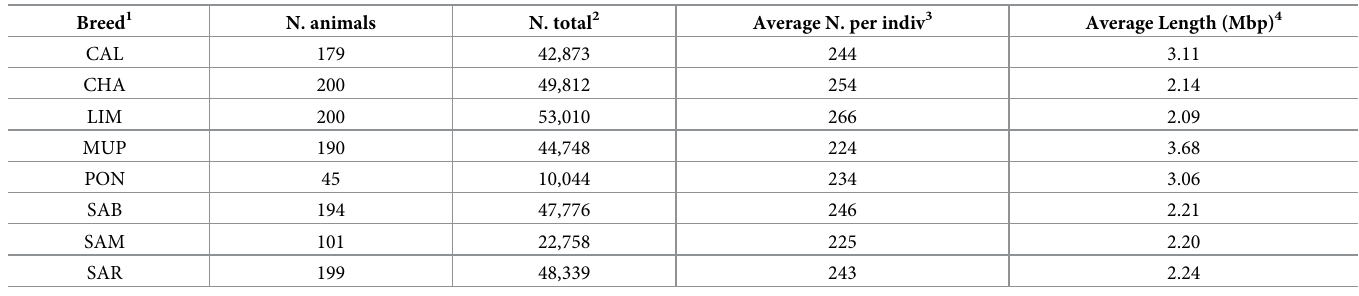
Table 2. Descriptive statistics of ROH for the eight breeds. Breed 1 N.